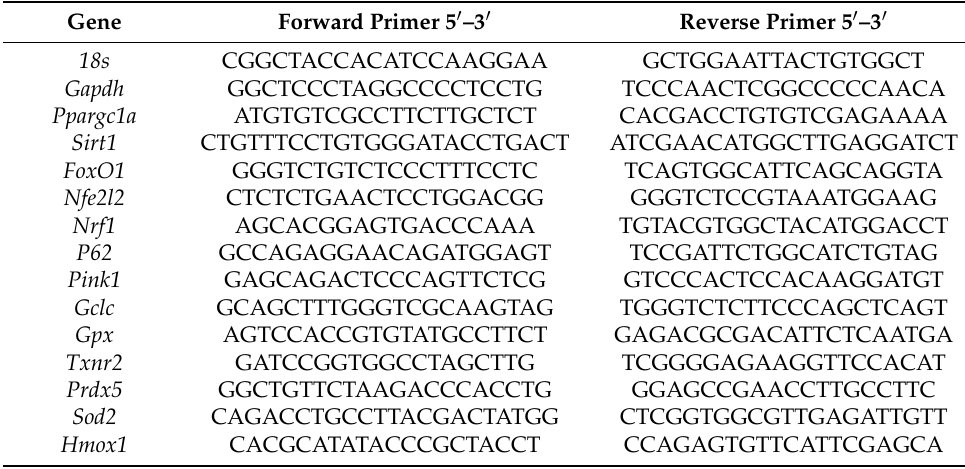
Table 8. Primer sequences for expression